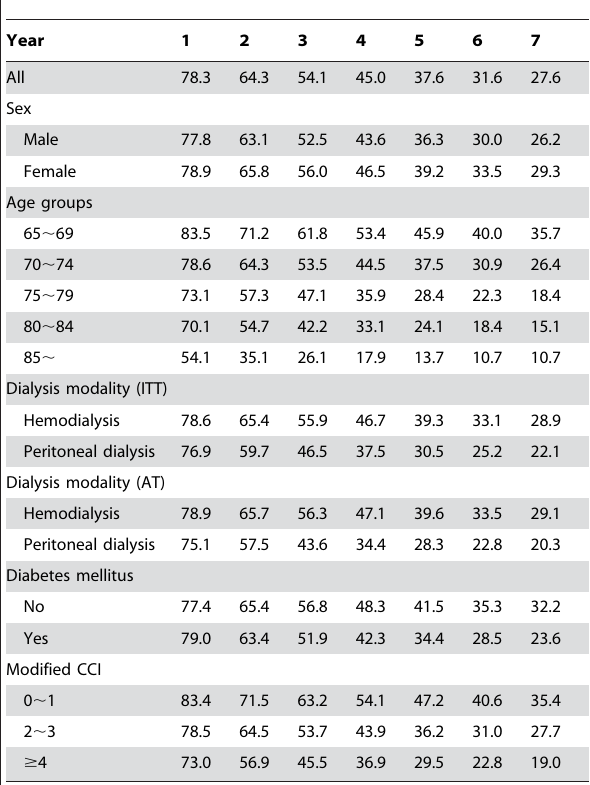
Table 2. Cumulative survival rate at each 1-year